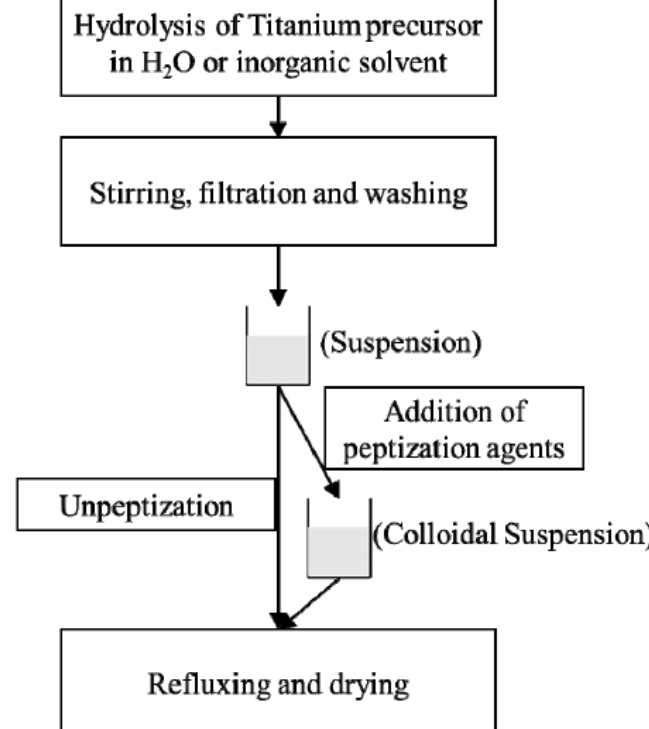
Fig. 1. Typical sol-gel methodology for the synthesis of NTPs, reprinted with permission from S. Winardi, R.R. Mukti, K.N.P. Kumar, J. Wang, W. Wunderlich and T. Okubo // Langmuir. 26 (2010) 4567, (c) 2010 American Chemical